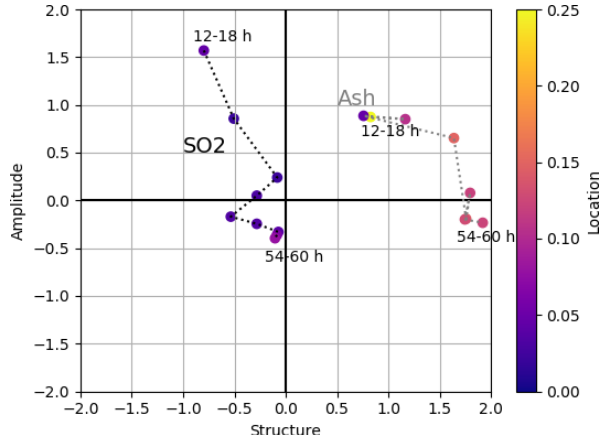
Figure 5. SAL values for ash and SO 2 in the reference experiment (FPlume-rad) with S (structure) on the abscissa, A (amplitude) on the ordinate, and L (location) in colors. The dotted lines connect consecutive hours to visualize the temporal development (black for SO 2 and gray for ash). The labels of the hours are given relative to the start of the simulation on 21 June 2019 at